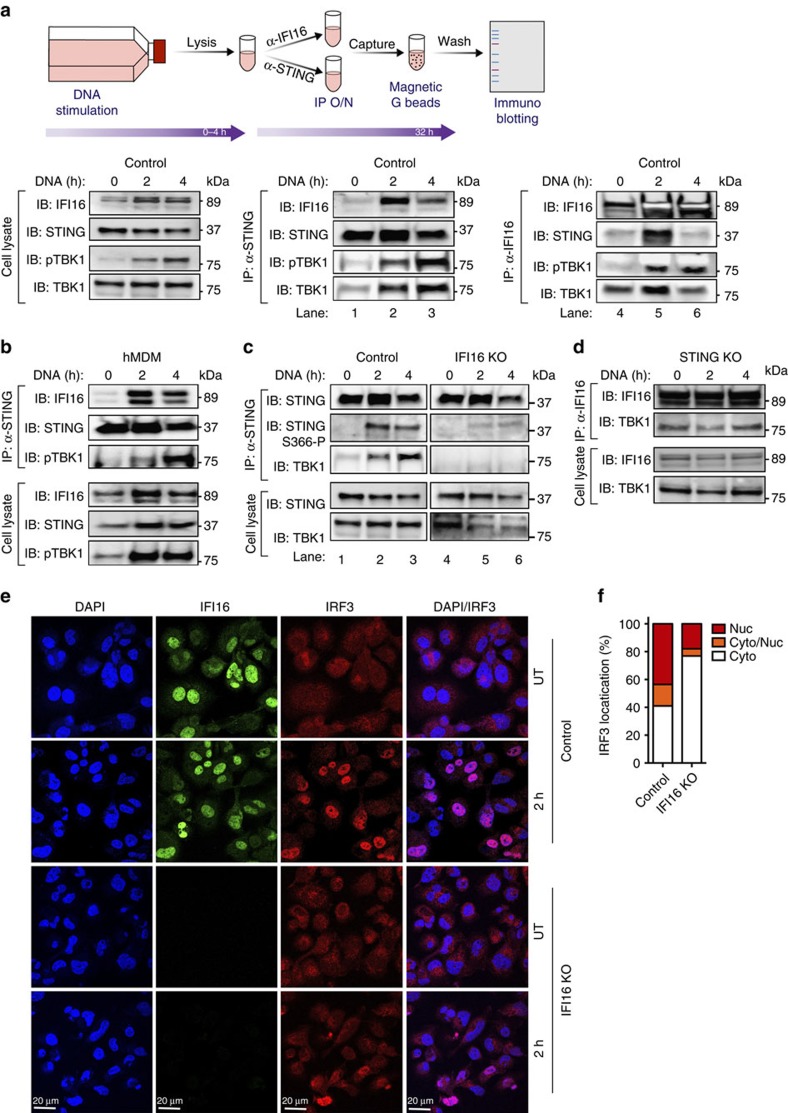
Recruitment of TBK1 to STING is dependent on IFI16 interactions.(a) Schematic illustration of the workflow of co-immunoprecipitation experiments. Cleared cell lysates (CCL) of THP-1 cells stimulated with dsDNA (4 μg ml−1) for 2 and 4 h were subjected to over-night co-immunoprecipitation with antibodies indicated in each panel. Lysates from control cells were co-IP with STING (lane 1–3) or IFI16 (lane 4–6). Input and elutes were analysed by gel electrophoresis followed by immunoblotting (IB) with the indicated antibodies. (b) STING co-IP samples from primary human MDMs after IB with the indicated antibodies. (c) STING co-IP samples from control (lane 1–3) and IFI16 KO (lane 4–6) THP-1 cells after IB with the indicated antibodies. (d) IFI16 co-IP samples from STING KO THP-1 cells after IB with the indicated antibodies. Each blot is representative of three independent experiments. (e) Control or IFI16 KO cells were stimulate with dsDNA (4 μg ml−1) for 2 h, fixed and stained for DAPI (blue), anti-IFI16 (green) or anti-IRF3 (red) and subjected to confocal imaging at × 63 oil lens. (f) Quantification of IRF3 localization of at least 50 individual cells treated as described in e.